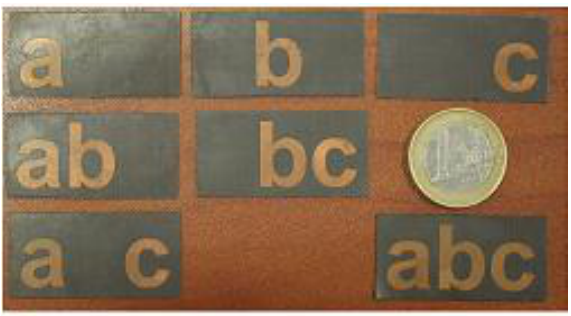
Figure 21. Set of manufactured letter-IDs tags.